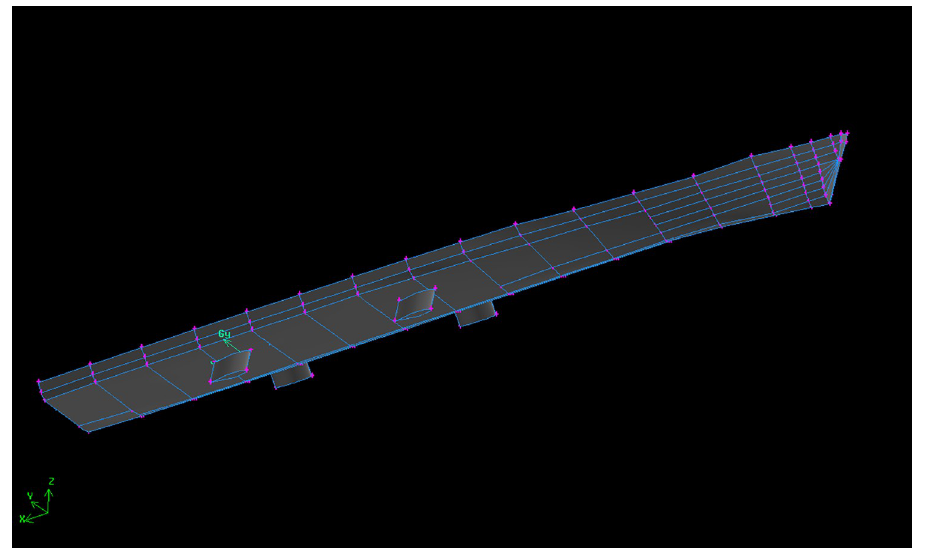
Fig 4. Ship model with fin stabilizers established in